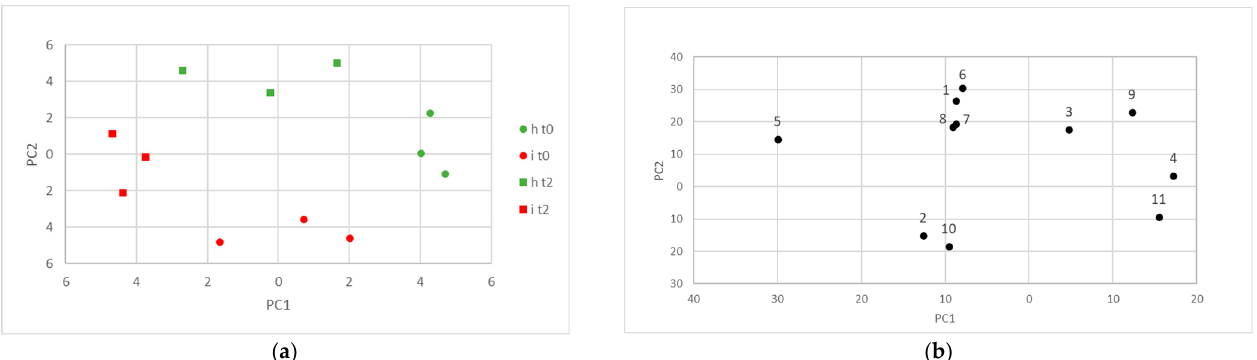
Figure 1. PLS-DA performed on the 11 VOCs identified in healthy (h) and OYDV-infected (i) samples for t 0 and t 2 sampling times. ( a ) Score plot for analyzed samples; ( b ) Loading plot for VOCs compounds (numbers correspond to those associated with compounds in Table 1).